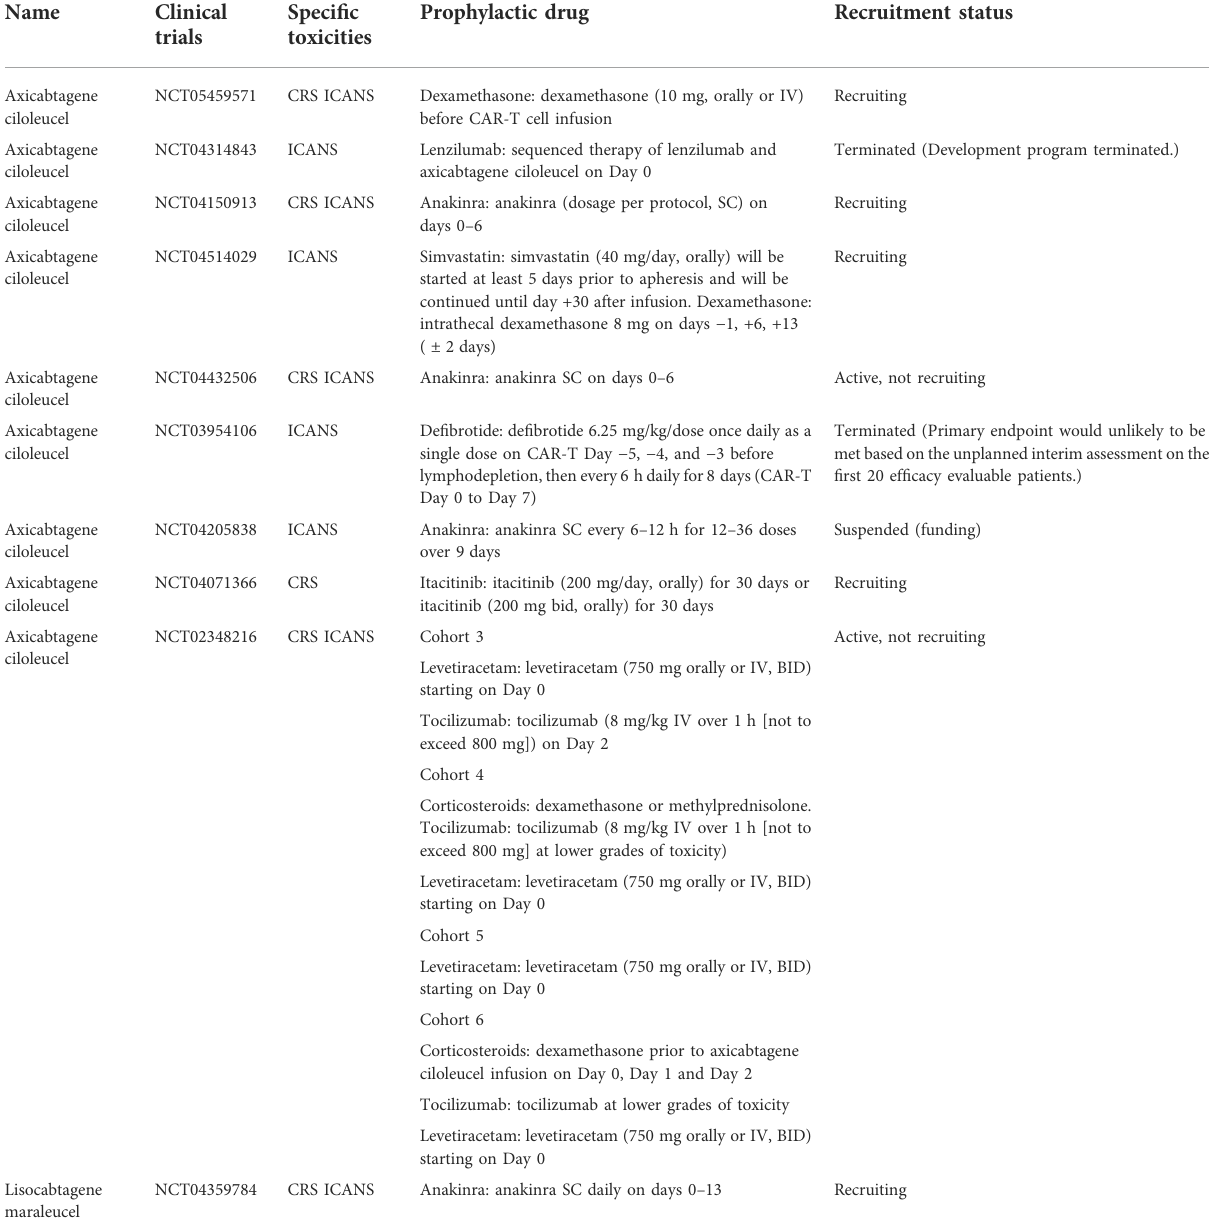
TABLE 5 Current interventional clinical trials aiming to reduce CAR-T speci fi c